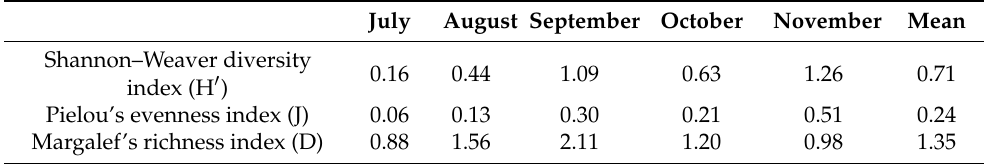
Table 7. Changes in phytoplankton biodiversity in the water surrounding the artificial reefs.